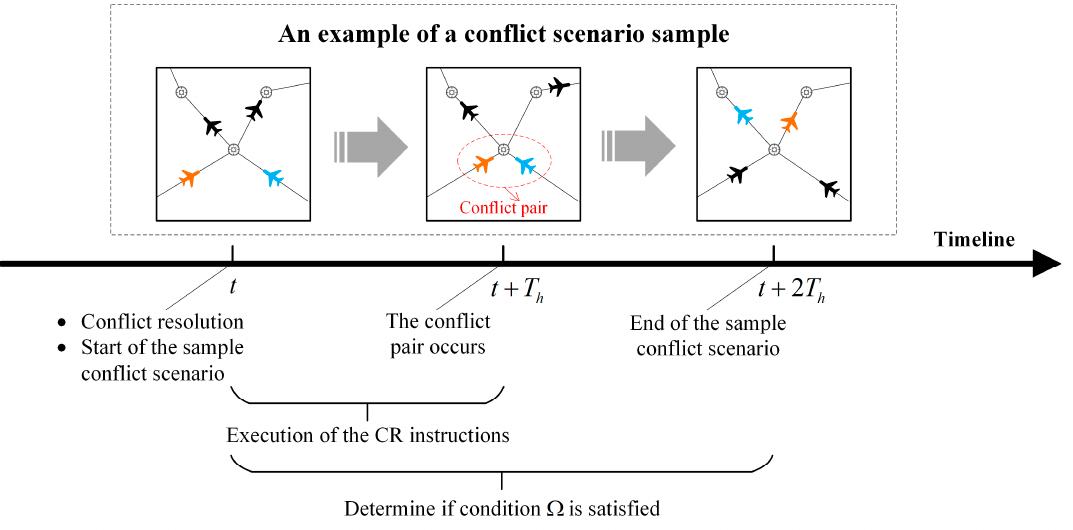
Figure 3. Schematic diagram of a conflict scenario.